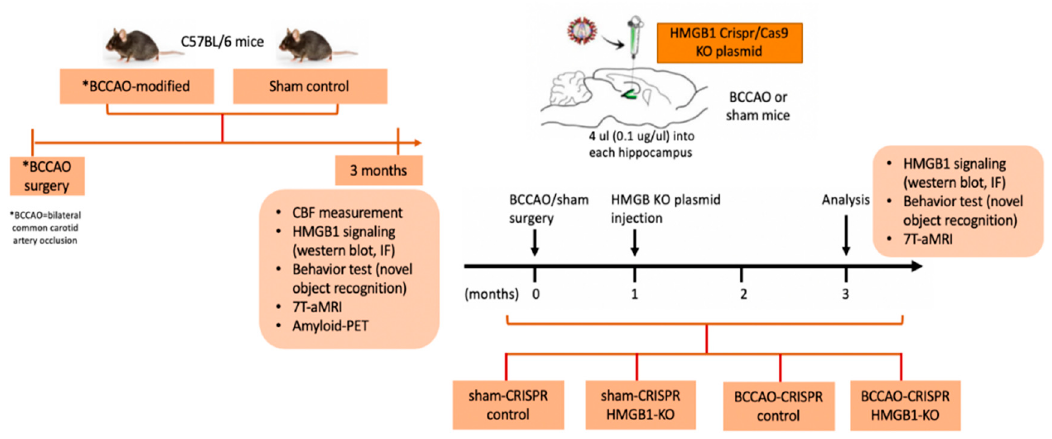
Figure 6. Schematic description of the experimental design.